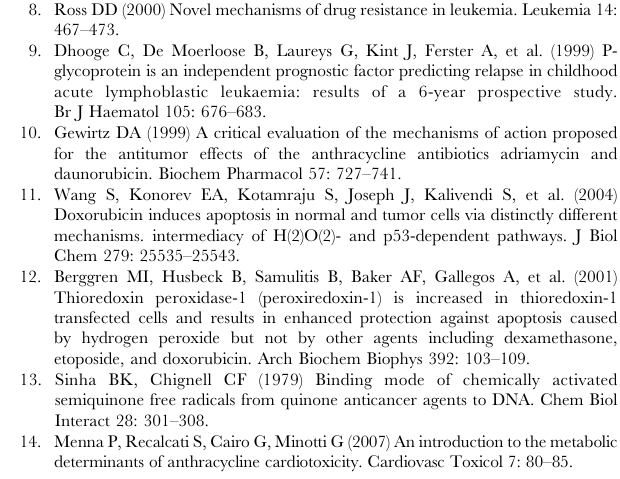
Figure S2 Doxorubicin transport for EU1 and EU3 cells are equivalent. Extracellular doxorubicin depletion for doxo- rubicin-resistant EU1 and doxorubicin-sensitive EU3 cells. ([Dox] = 10 m M for 1 hr; *p , 0.05). Figure S3 Basal NADPH levels are significantly differ- ent between the EU1 and EU3 cells. Relative basal intracellular [NADPH] in doxorubicin-resistant EU1 and doxo-